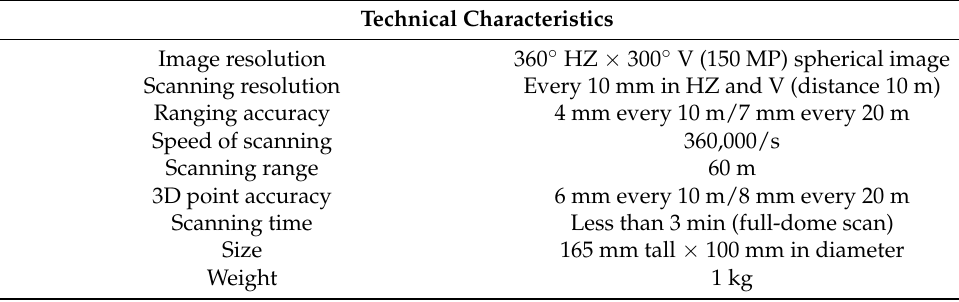
Table 2. Technical characteristics of the BLK 360 laser scanning